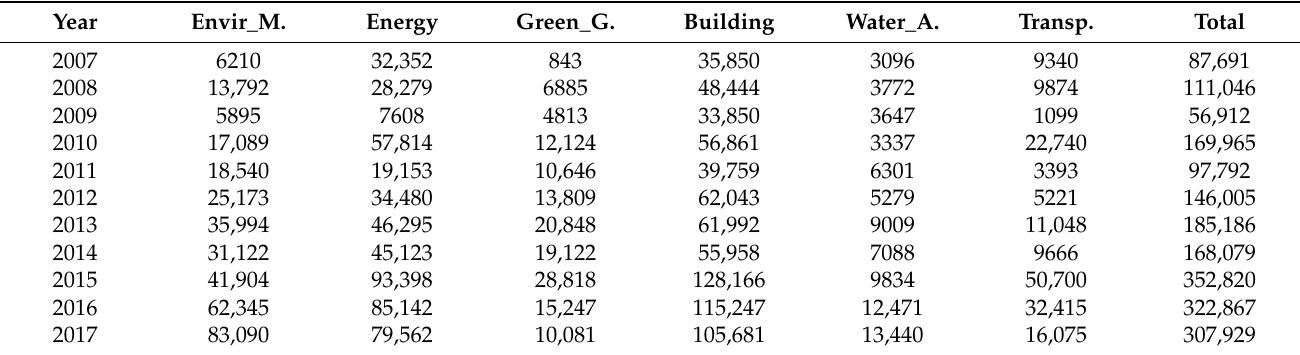
Table 1. Number of environment-related patent applications in different technical fields from 2007 to 2017 in China.